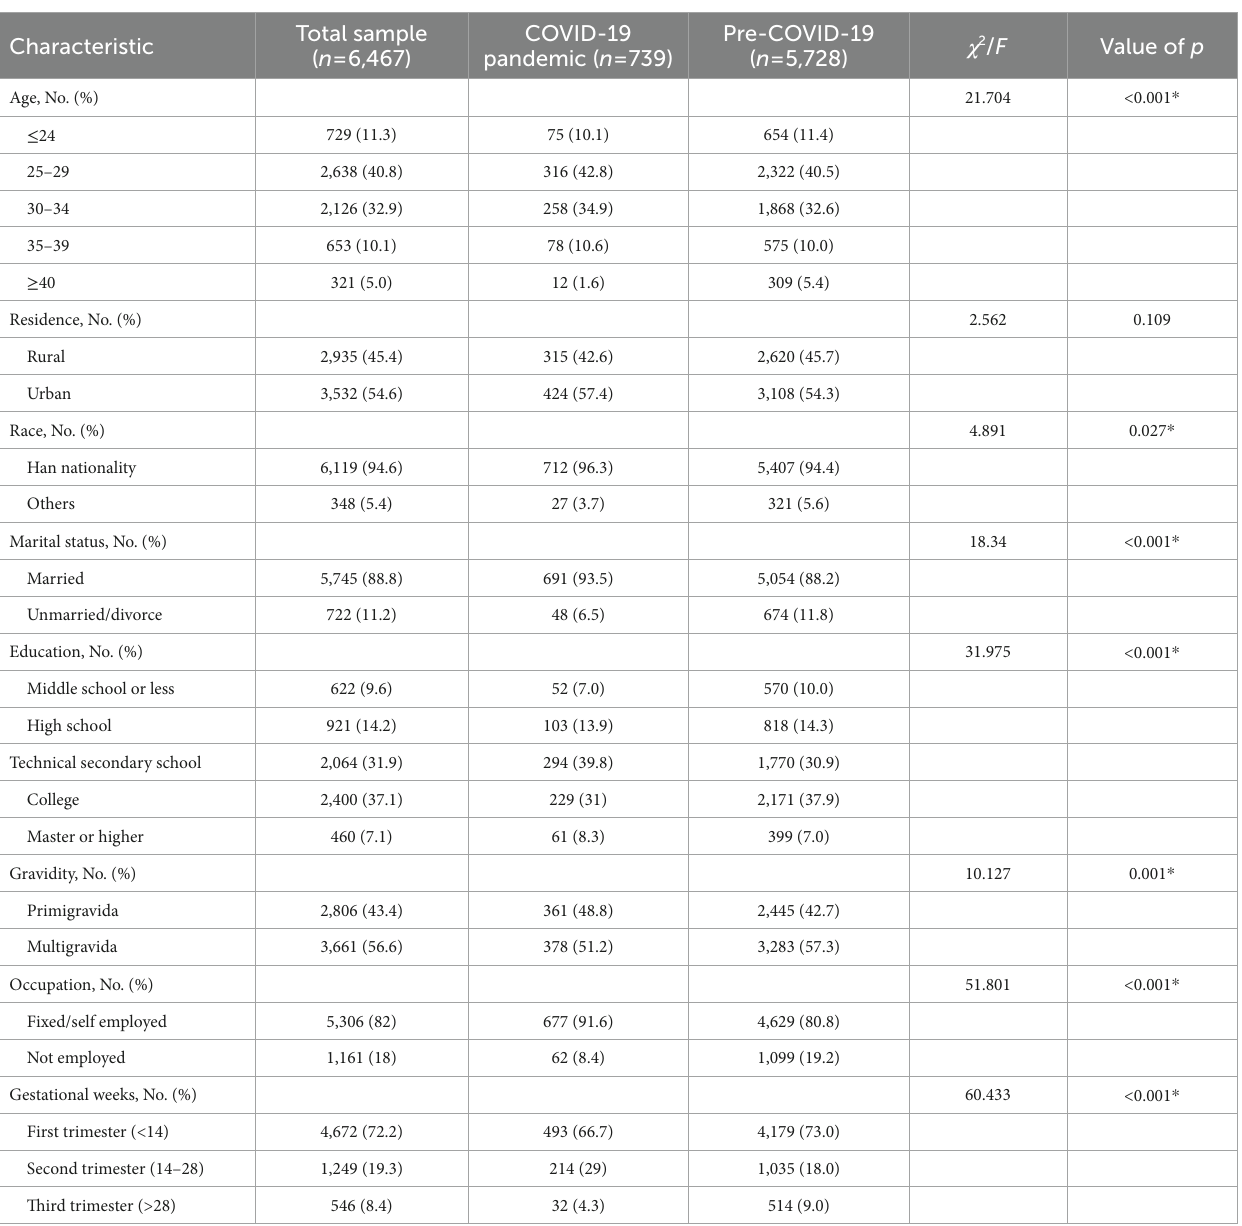
TABLE 1 Demographic characteristics of the two